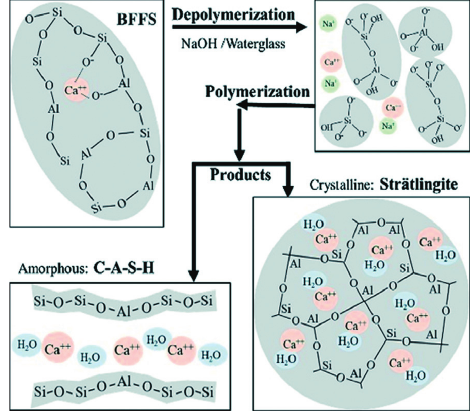
Figure 4: Reaction mechanism of alkali-activated blast furnace ferronickel slag